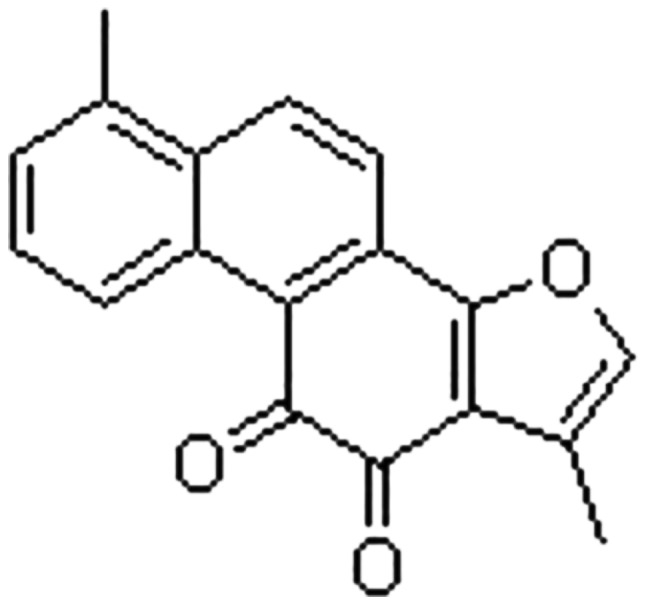
Molecular formula of tanshinone I (molecular weight = 276.29 g/mol). (Source: http://www.chemblink.com/products/568-73-0.htm; accessed on July 23, 2013).